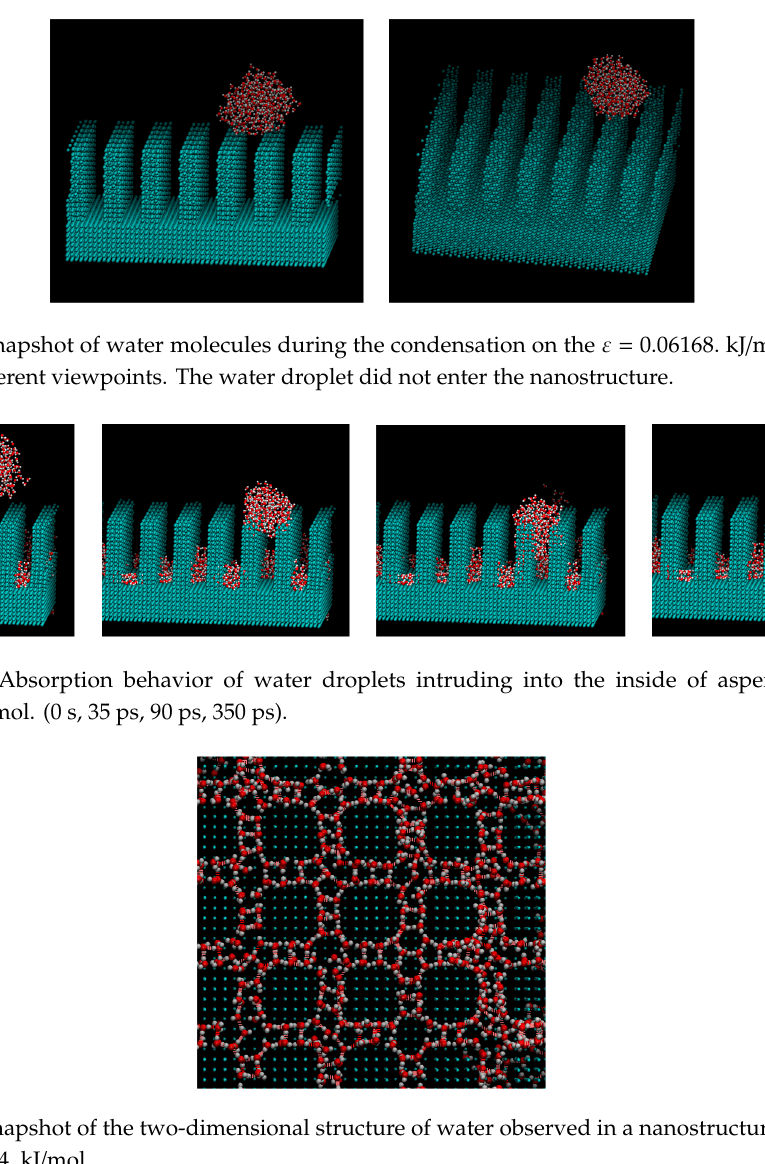
Figure 10. Snapshot of water molecules during the condensation on the ε = 1.974. kJ/mol surface from the different viewpoints. The water molecules formed small clusters in the pillar.